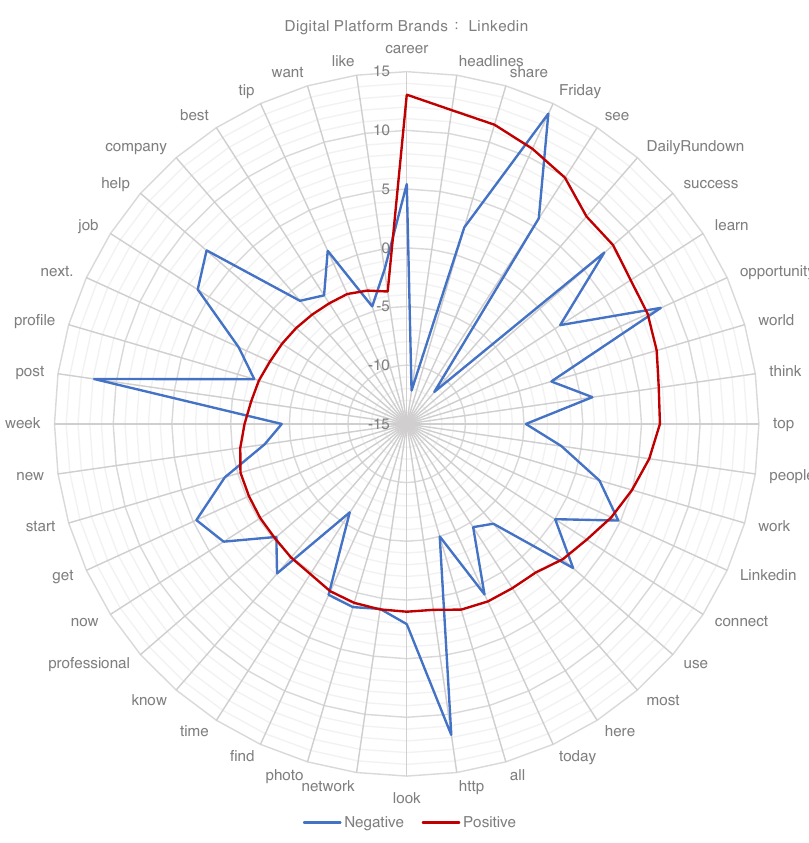
Fig. 10 Cues of Linkedin, positive and negative clues in the postings on the “ Linkedin ” fan